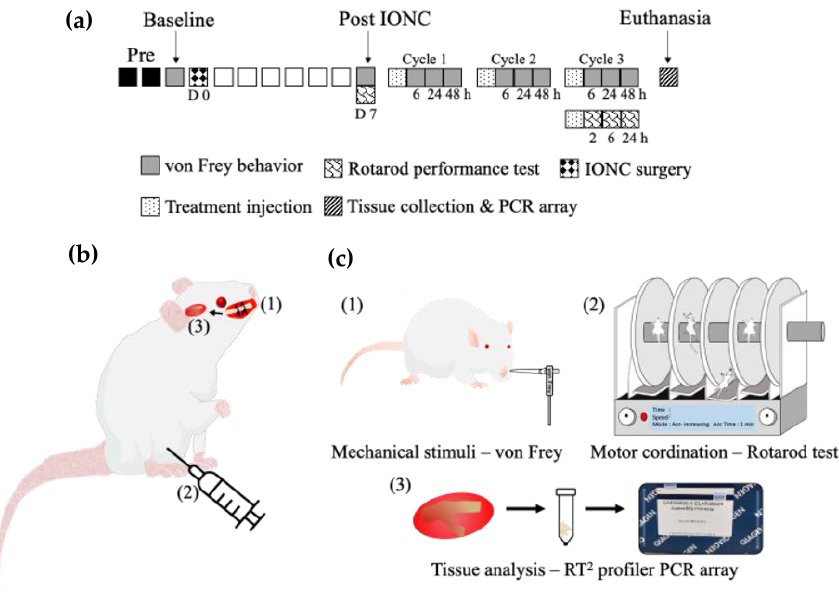
Figure 8. Scheme for the experiment timeline, neuropathic pain model, and methods. ( a ) The experiment timeline showing the procedures in the neuropathic pain model. (D: Day, IONC: Infraorbital nerve constriction). ( b ) Neuropathic pain model, (1) IONC, (2) treatment injection — tranilast/carbamazepine/saline, (3) trigeminal ganglion tissue. ( c ) Evaluation tests conducted: (1) pain behavior tested as a response to mechanical stimuli using the von Frey test; (2) motor coordination assessed with the rotarod performance test; (3) trigeminal ganglion tissues analyzed using an RT 2 profiler PCR array.